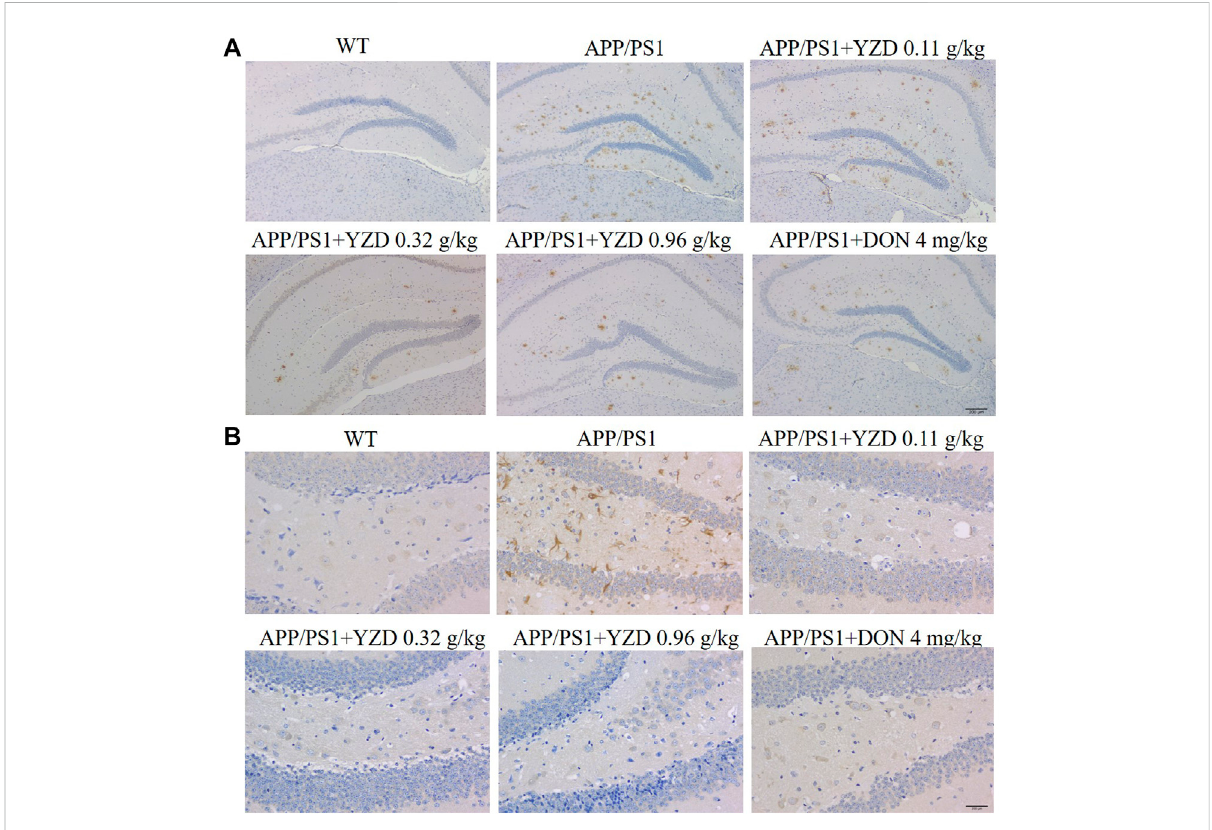
FIGURE 9 YZD inhibited A β and Tau deposition in the hippocampi of APP/PS1 mice. (A) Representative images of A β deposits (showing brown staining) in the hippocampi. Magni fi cation: ×25, scale bar: 200 μ m. (B) Images of Tau deposits in the hippocampi (appearing as brown deposits). Magni fi cation: 400 × scale bar: 200 μ